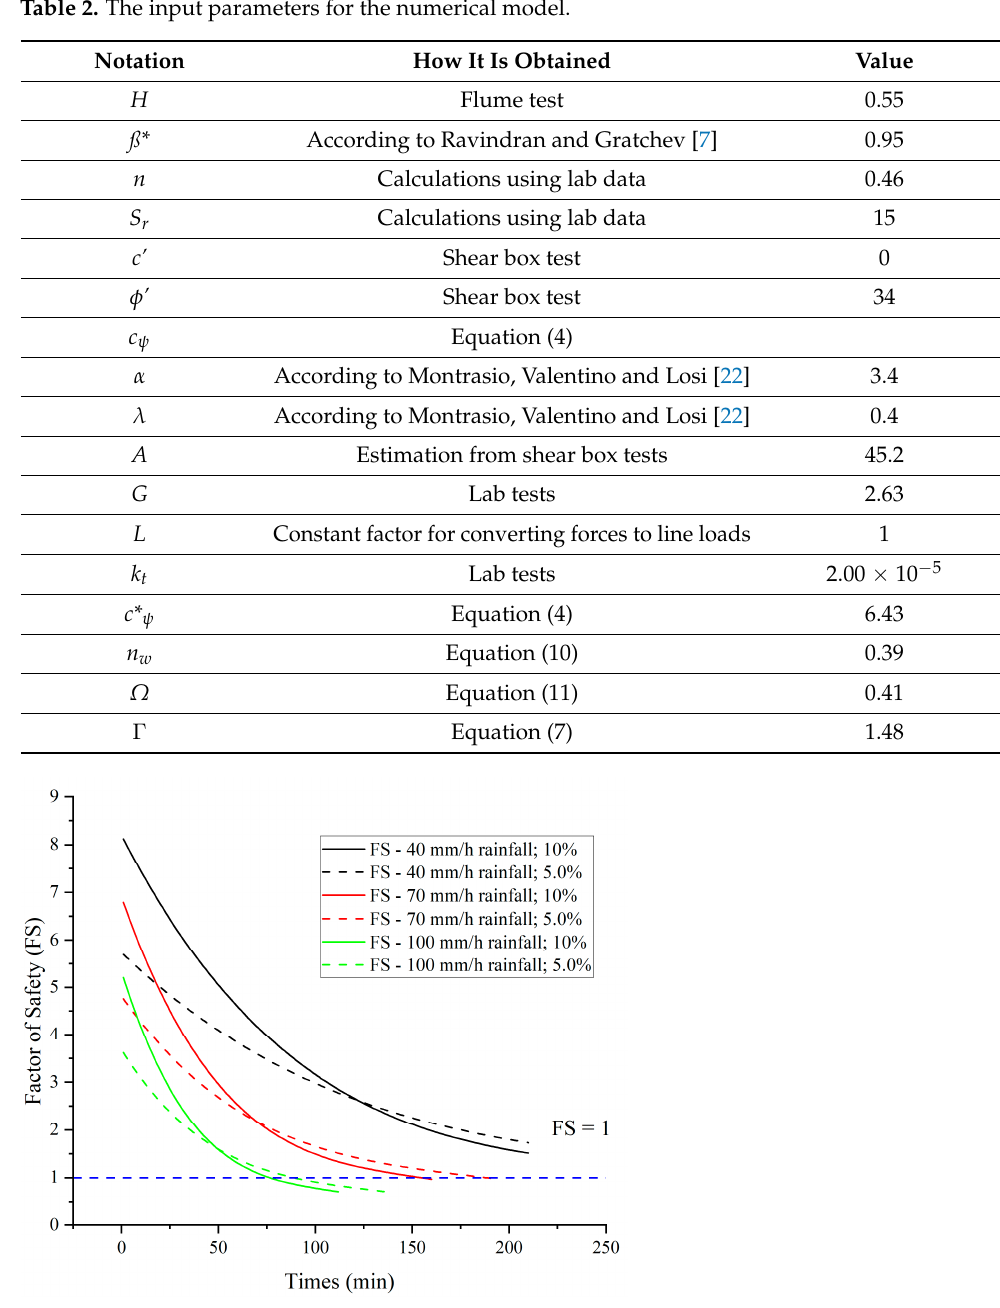
Figure 8. Results of the numerical analysis plotted as time series data of the factor of safety obtained for different rainfall intensities and the initial moisture content. Table 3. Comparison of the time of slope failure from the flume test and numerical analysis. Test